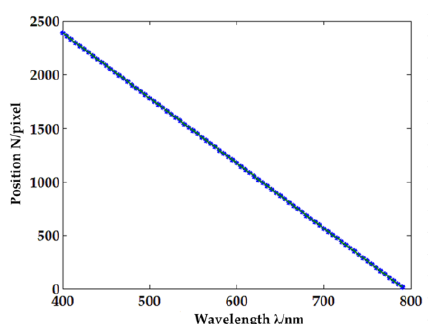
Figure 5. Relationship between pixel position N and wavelength λ